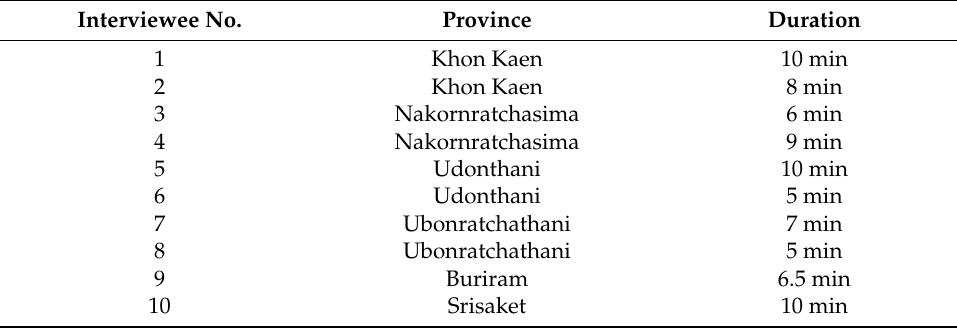
Table A1. Interviews and Interviewees of Thai Participants: Segment 1.